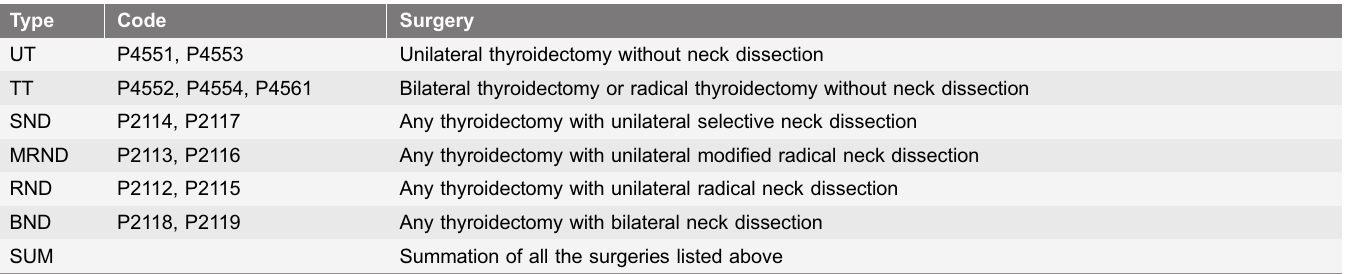
Table 1. Types of thyroid cancer